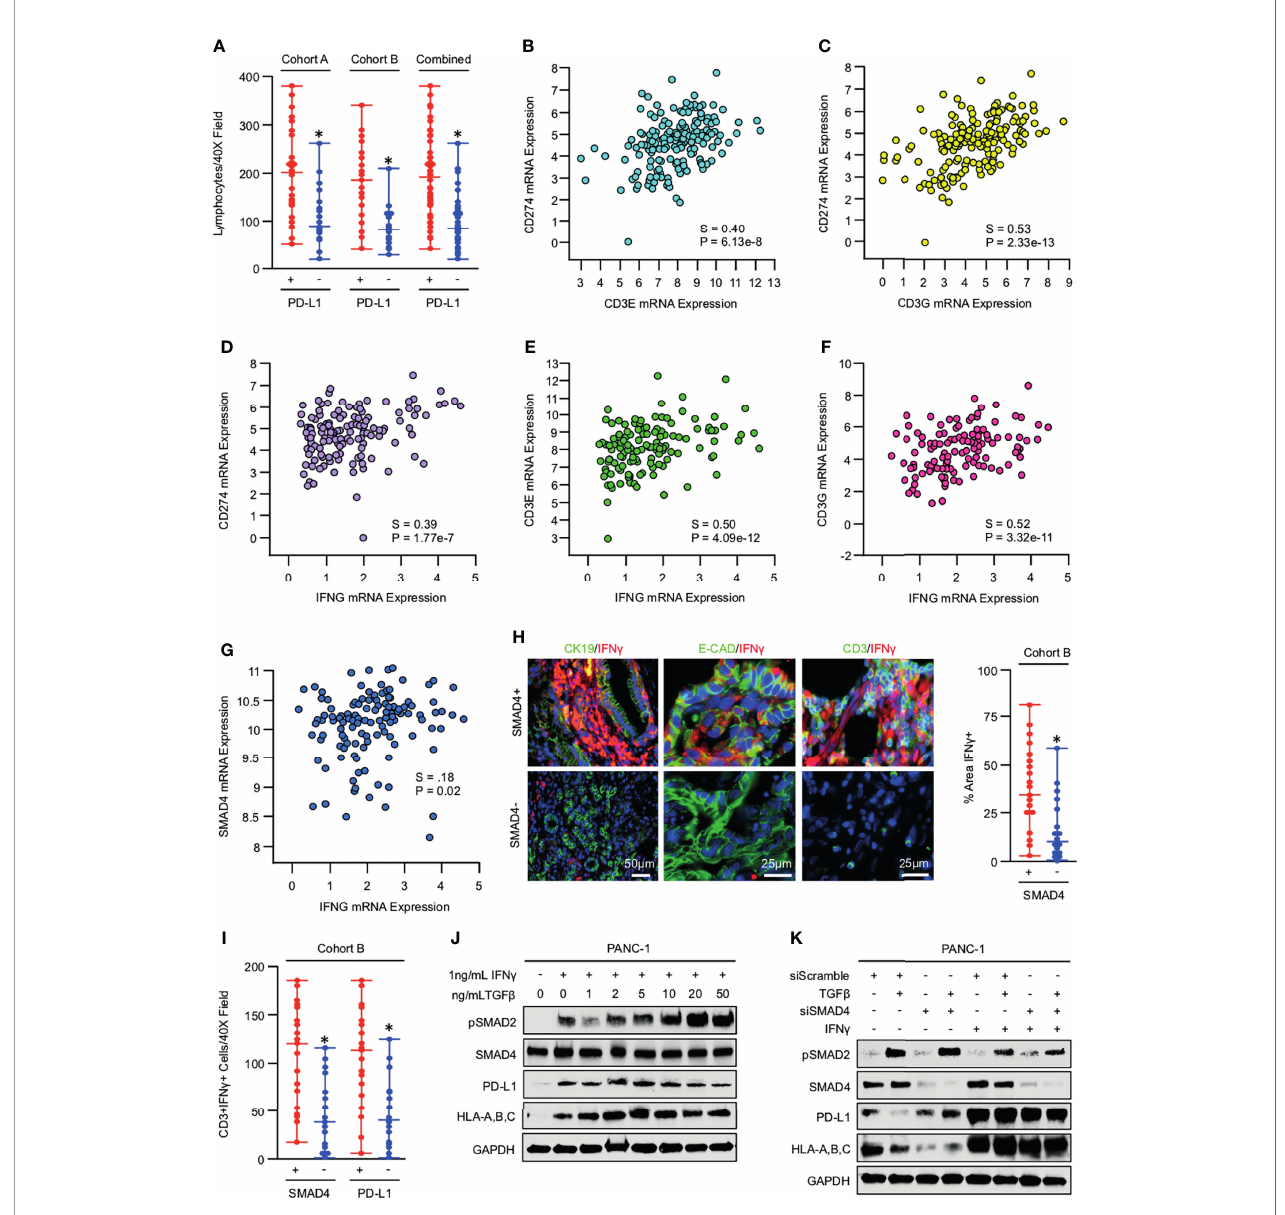
FIGURE 6 | IFN g overcomes the inhibitory effects of TGF b /SMAD signaling on PD-L1 expression both in vivo and in vitro. (A) Excisional biopsies from 44 PDAC patients in cohort A and 36 PDAC patients in cohort B were sectioned and stained with H&E, lymphocytes quanti fi ed per 40X fi eld, and arranged by PD-L1 status. (B-D) Using the TCGA genomic database of pancreatic cancer patients, CD274 mRNA expression was plotted against that of CD3E , CD3G , and IFNG . (E-G) Also, using the TCGA genomic database, IFNG mRNA expression was plotted against that of CD3E , CD3G , or SMAD4. ( H ) The 36 excisional PDAC specimens from cohort B were stained by immunohistochemistry for IFN g , as well as dual-stained for either the duct marker CK19 and IFN g , epithelial surrogate marker E-Cadherin and IFN g , or the T-cell marker CD3 and IFN g . The percent area positive for IFN g was quanti fi ed as described and related to SMAD4 status. (I) The number of CD3 +IFN g + cells were quanti fi ed per 40X fi eld and arranged by both SMAD4 and PD-L1 status. (J) PANC-1 cells were incubated with 1ng/mL of recombinant IFN g in the presence of increasing doses of recombinant TGF b 1, and PD-L1 expression evaluated by western blot after 24 hours. (K) PANC-1 cells were again incubated with either siControl or siSMAD4 and, after 24 hours, stimulated with 10ng/mL of recombinant TGF b 1. This experiment was also conducted in the presence of 1ng/mL recombinant IFN g given concurrently with TGF b 1, and 24-hours after stimulation, cells were evaluated by western blot. (*p <